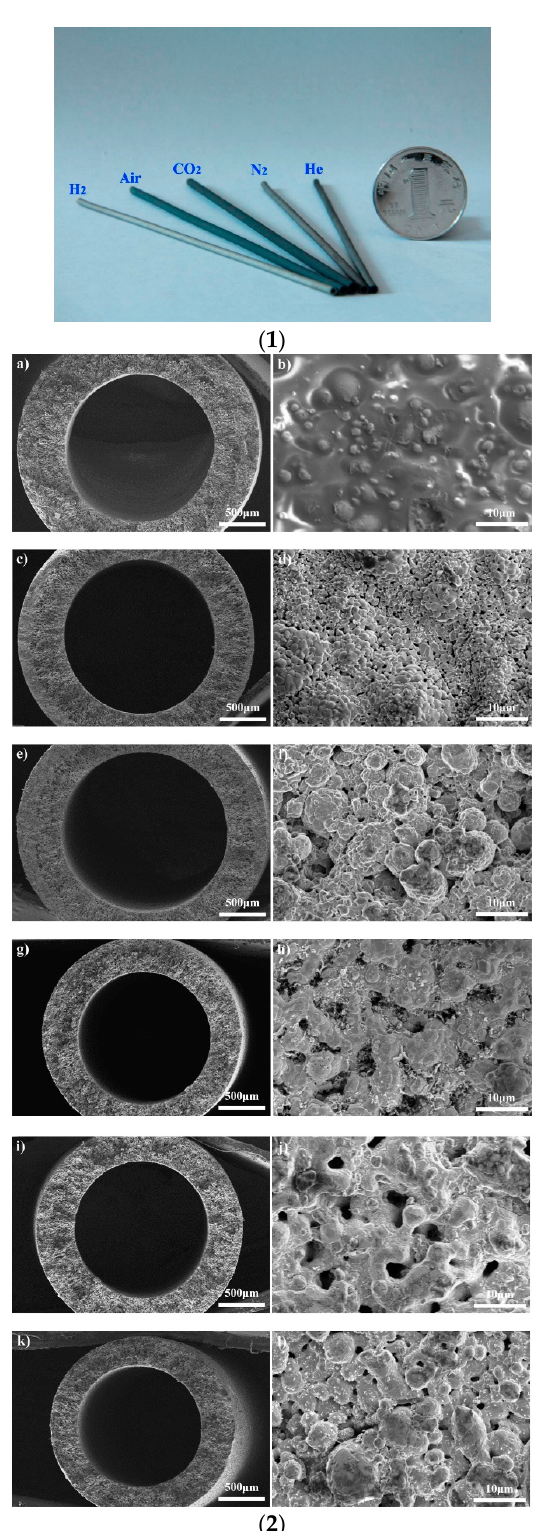
Figure 1. ( 1 ) Stainless steel hollow fibres prepared under various atmospheres; ( 2 ) Scanning electron microscopy (SEM) measurements on the cross-sections and surfaces of samples before and after sintering under various atmospheres: fibre precursor ( a , b ), with air ( c , d ), with CO 2 ( e , f ), with N 2 ( g , h ), with He ( i , j ), and with H 2 ( k , l ). Reprinted from “Effects of sintering atmospheres on properties of stainless steel porous hollow fiber membranes” [84], © 2015, with permission from Elsevier.